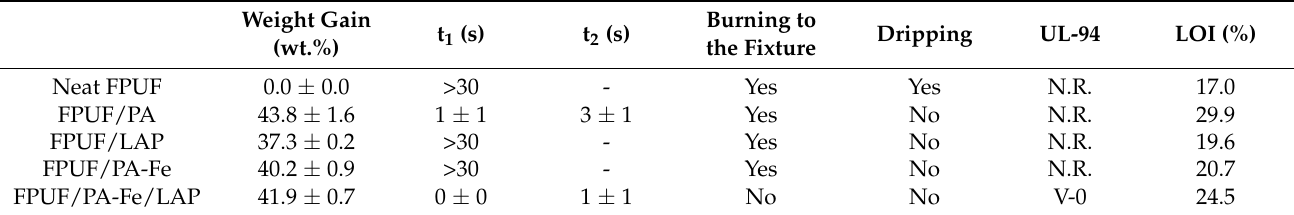
Figure 6. Digital images of neat FPUF, FPUF/PA, FPUF/LAP, FPUF/PA-Fe, and FPUF/PA-Fe/LAP during UL-94. Table 3. The detailed data of UL-94 and